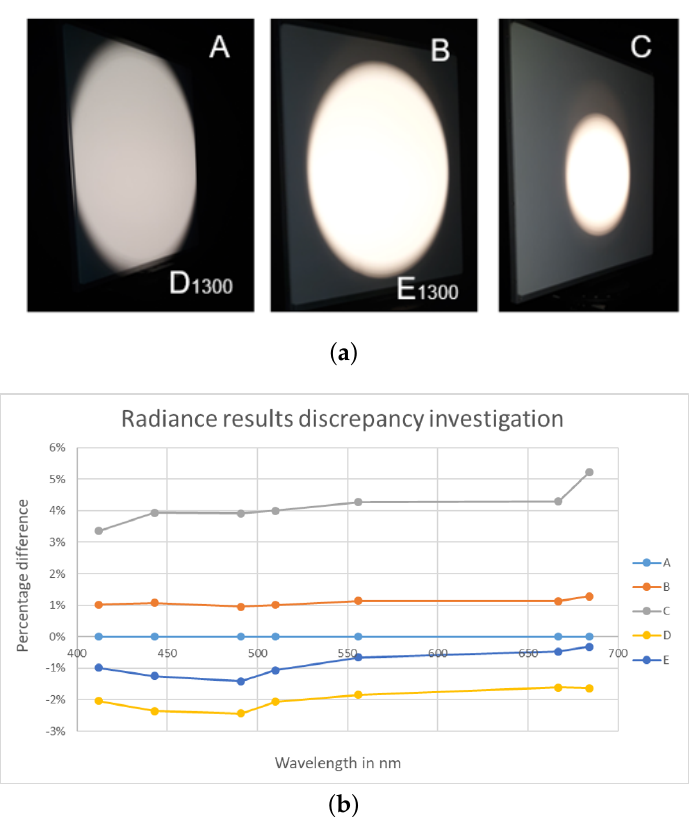
Figure 7. Difference in the radiance measurement due to the distance setting and the size of the source. ( a ) Photographs of illumination patch sizes.The photograph on the left presents cases A and D, the middle one cases B and E, and the right hand side case C. ( b ) Plot with percentage difference between measurements for different patch size and lamp-panel distance